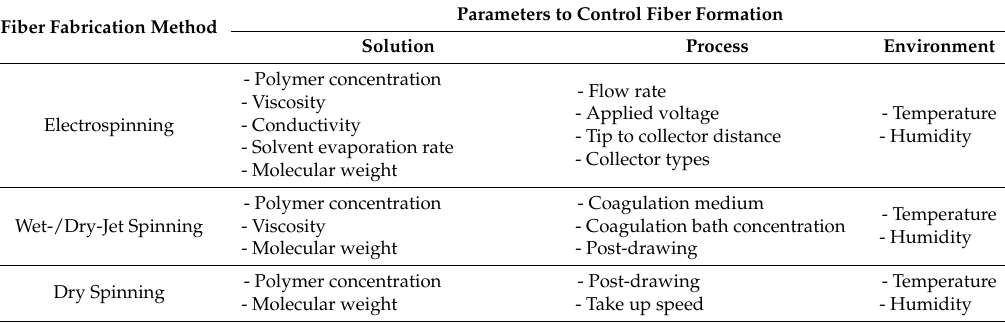
Table 1. Parameters of fabrication methods affecting fiber properties